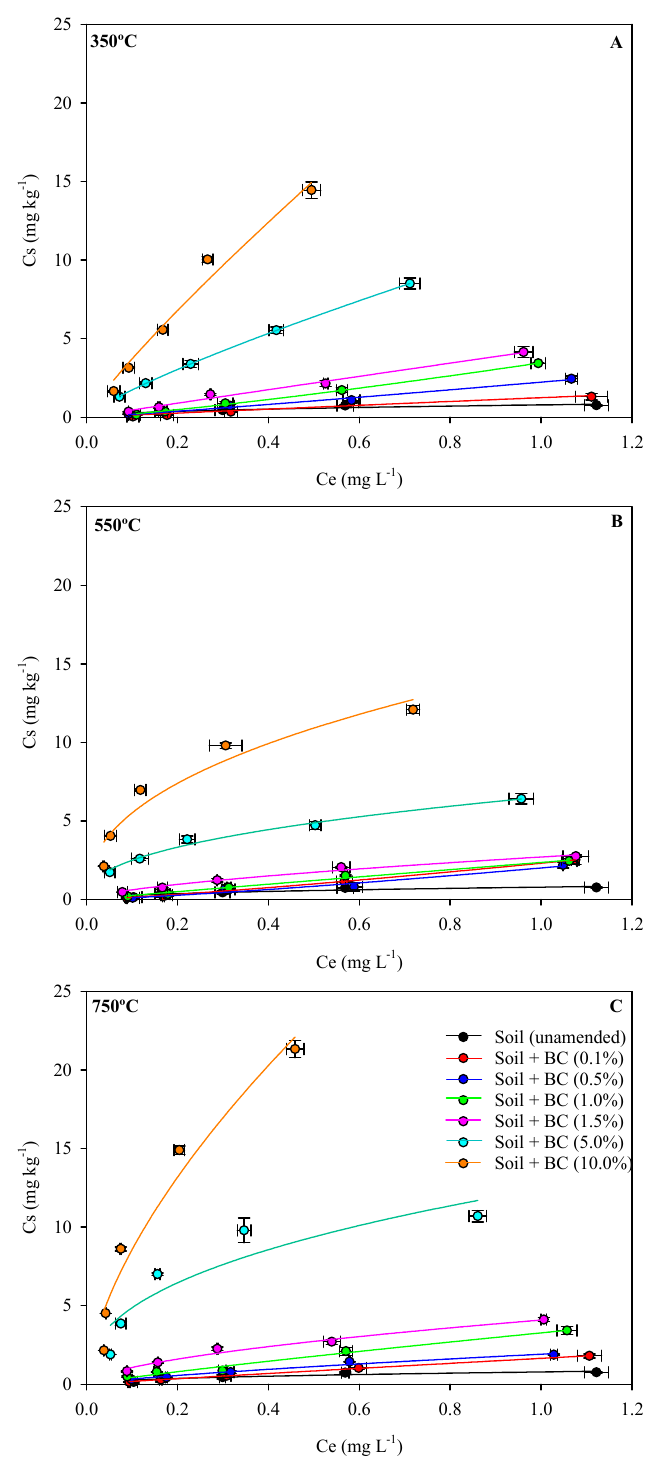
Figure 3. Desorption isotherms of the Freundlich model of metribuzin applied in soil amended and unamended (control) with sugarcane straw biochar (BC) produced at pyrolysis temperatures of 350 ◦ C ( A ) , 550 ◦ C ( B ) and 750 ◦ C ( C ). The vertical and horizontal bars represent standard error ( n = 3) of Ce (equilibrium concentration) and Cs (soil concentration). Symbols can cover the bars.